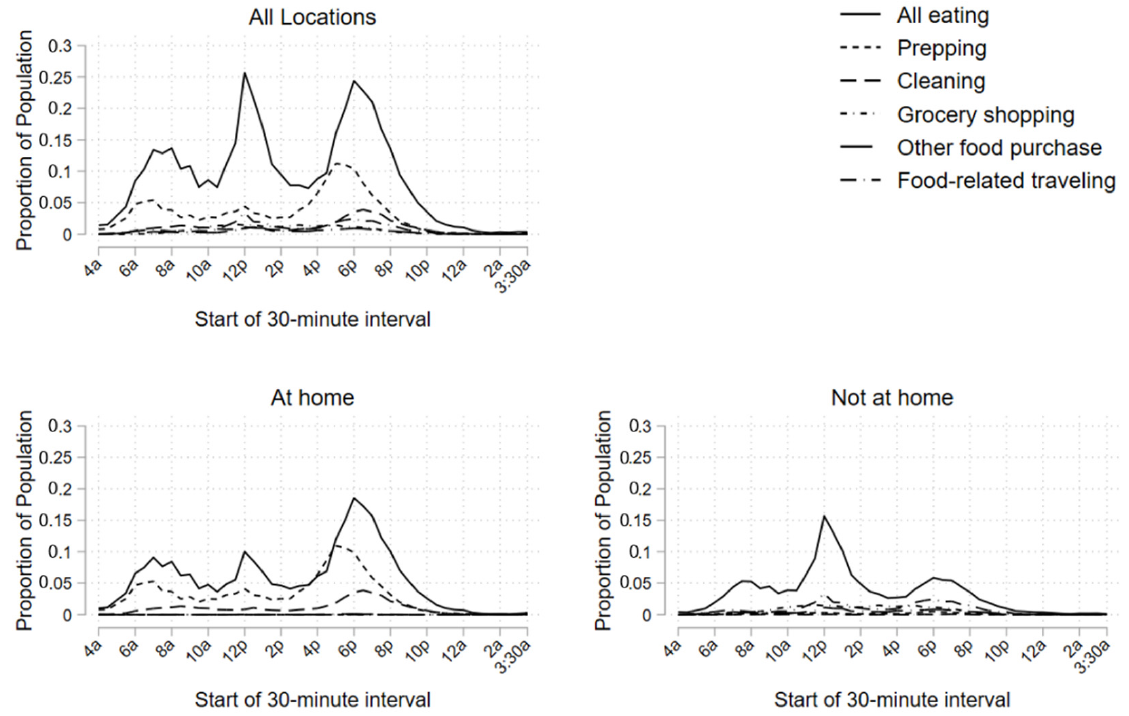
Figure 2. Proportion of population participating in all food-related activities by interval and loca- tion.